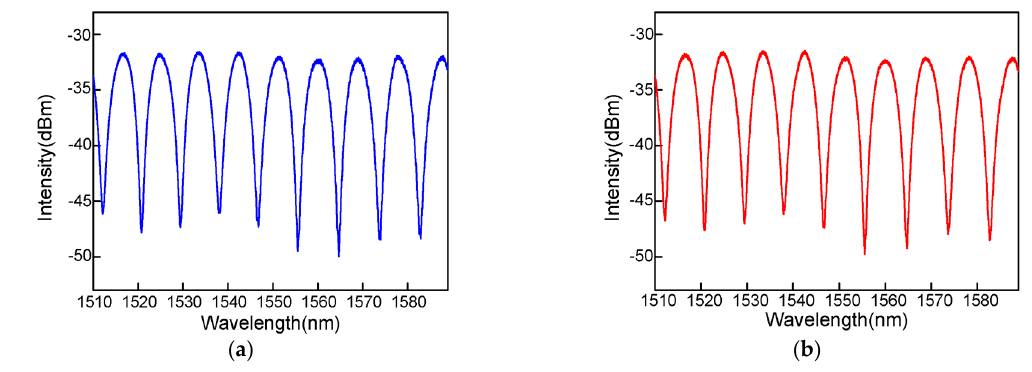
Figure 4. ( a , b ) Interference spectrum of the proposed sensor using the same parameters at different time.